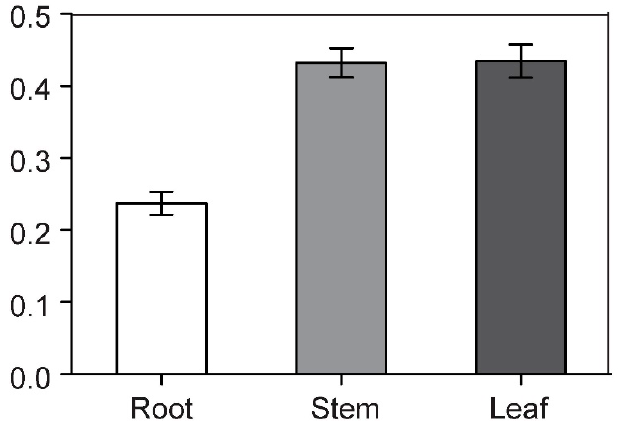
Figure 6. RT-qPCR analysis of the expression patterns of BcCSP3 in roots, stems and leaves of Pak-choi. Each column represents the average and standard deviation of three replicates. Each bar value represents the mean ± SD ( p < 0.05).